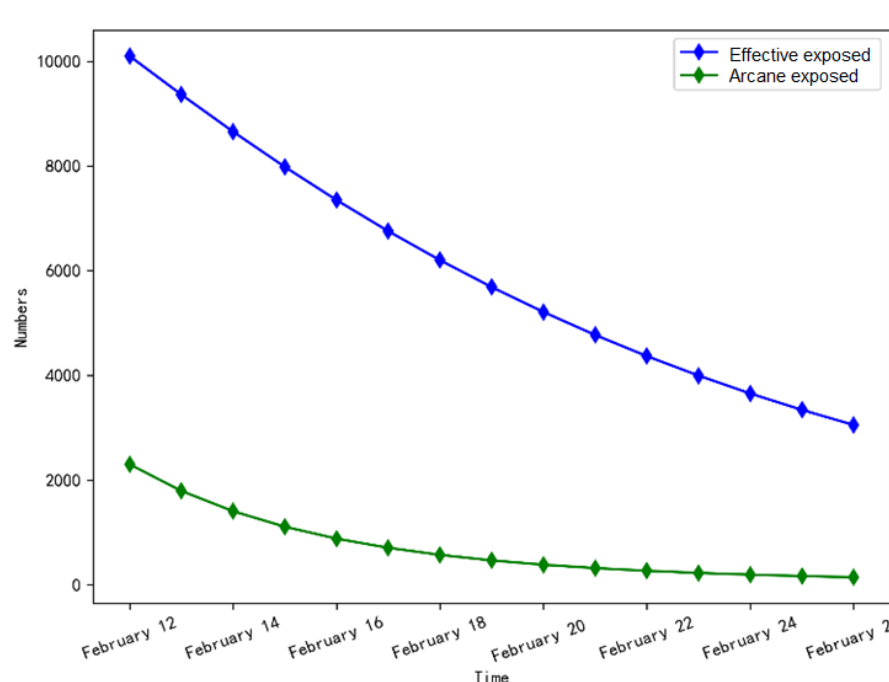
Figure 7. The number of exposed persons change in stage 2.